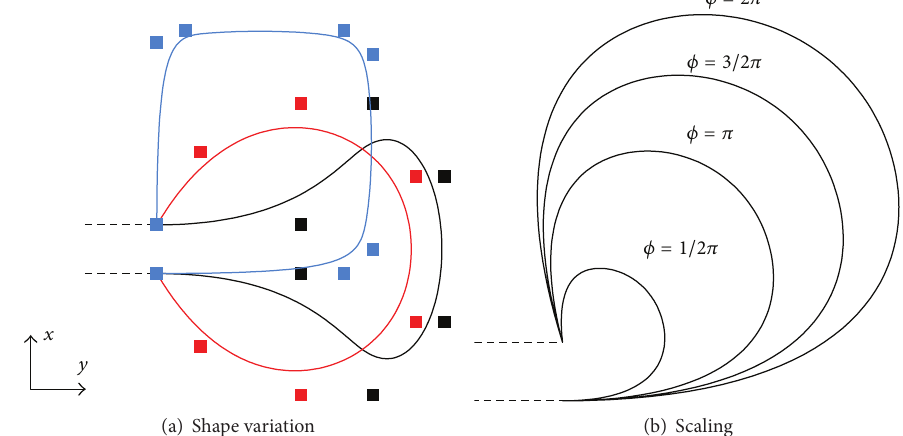
Figure 5: Three different volute shapes represented by B-splines using eight control points (a) and scaling of the volute shape cross-sectional areas as a function of the azimuthal angle 𝜙 (b).